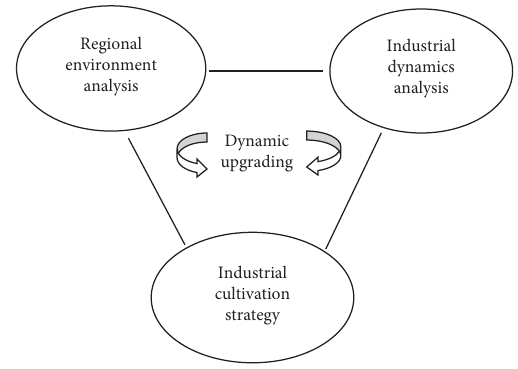
Figure 1: Double helix